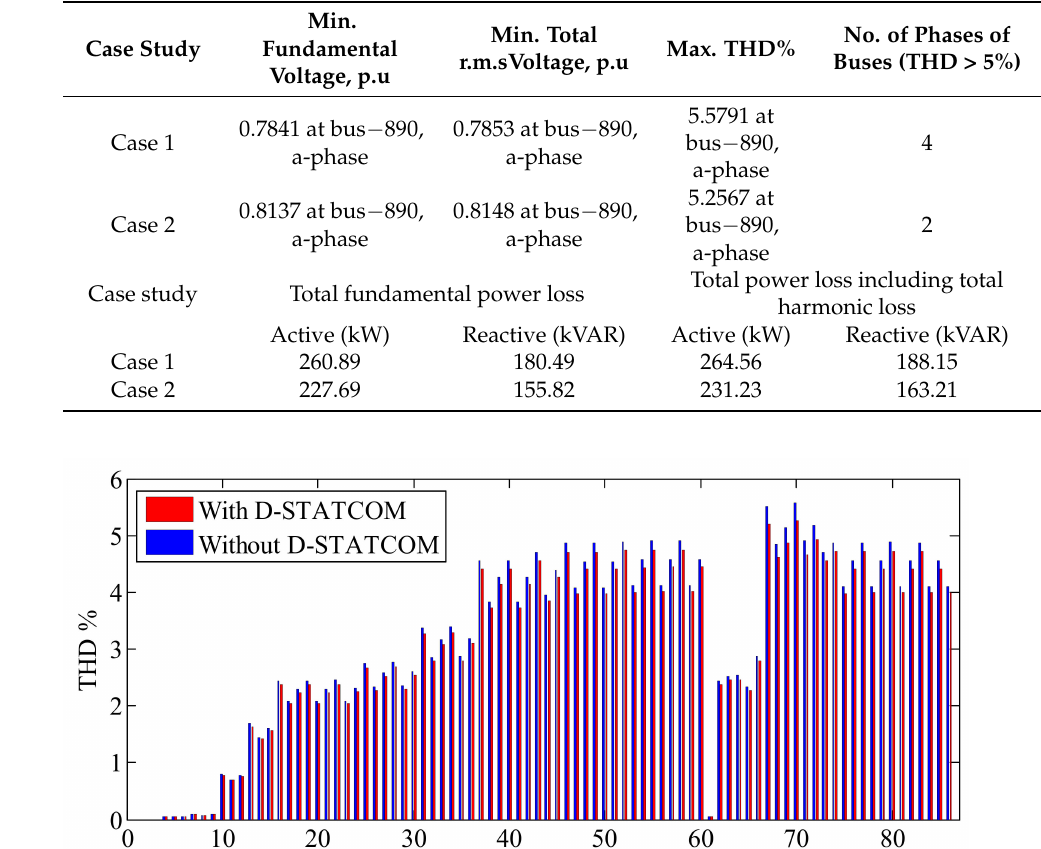
Table 13. Summary of results for the case studies on IEEE − 34 bus URDN.